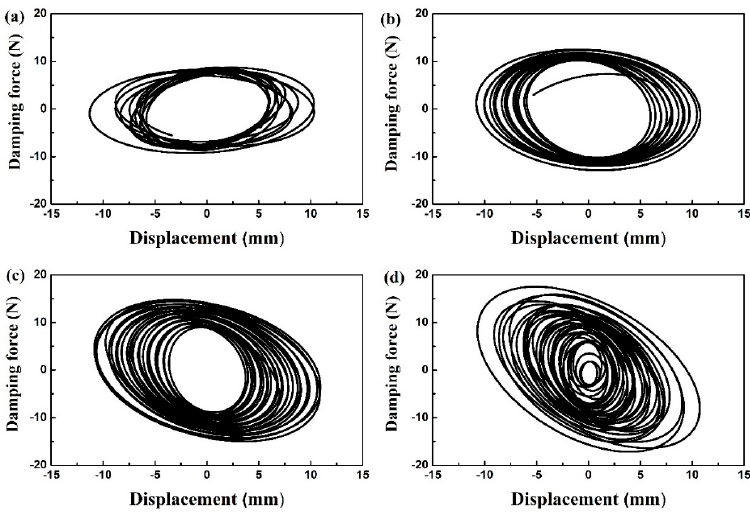
Figure 11. The damping force versus the linear displacement of the DC generator.( a )First mode;( b ) Second mode; ( c )Third mode; and ( d )Fourth mode.